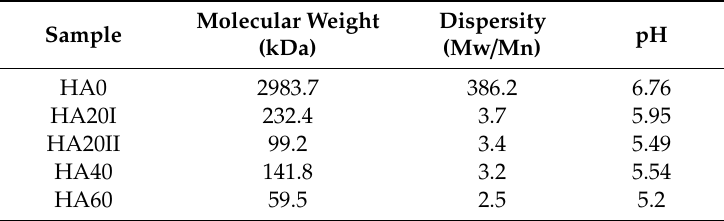
Table 1. Molecular weights, dispersity and pH values of LMWHA irradiated with various doses of γ -irradiation.